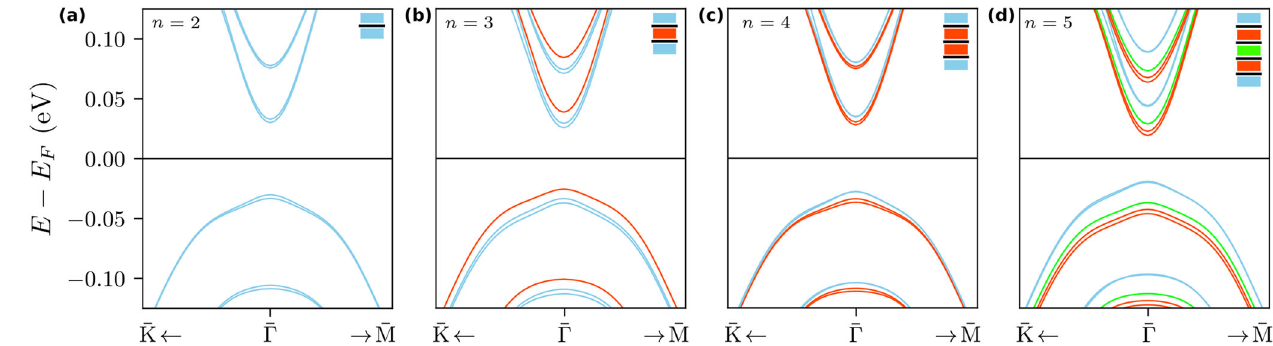
Fig. 3 Electronic band structures of the n MBT 2SL /hBN multilayers. Calculations were performed along the K (cid:2) Γ (cid:2) M path in the 2D Brillouin zone for a n = 2, b n = 3, c n = 4, and d n = 5. In the insets, the colored blocks depict the equivalent MBT 2SL layers from which the bands of the corresponding color dominantly stem. The black lines between the blocks represent the hBN layers that separate them.